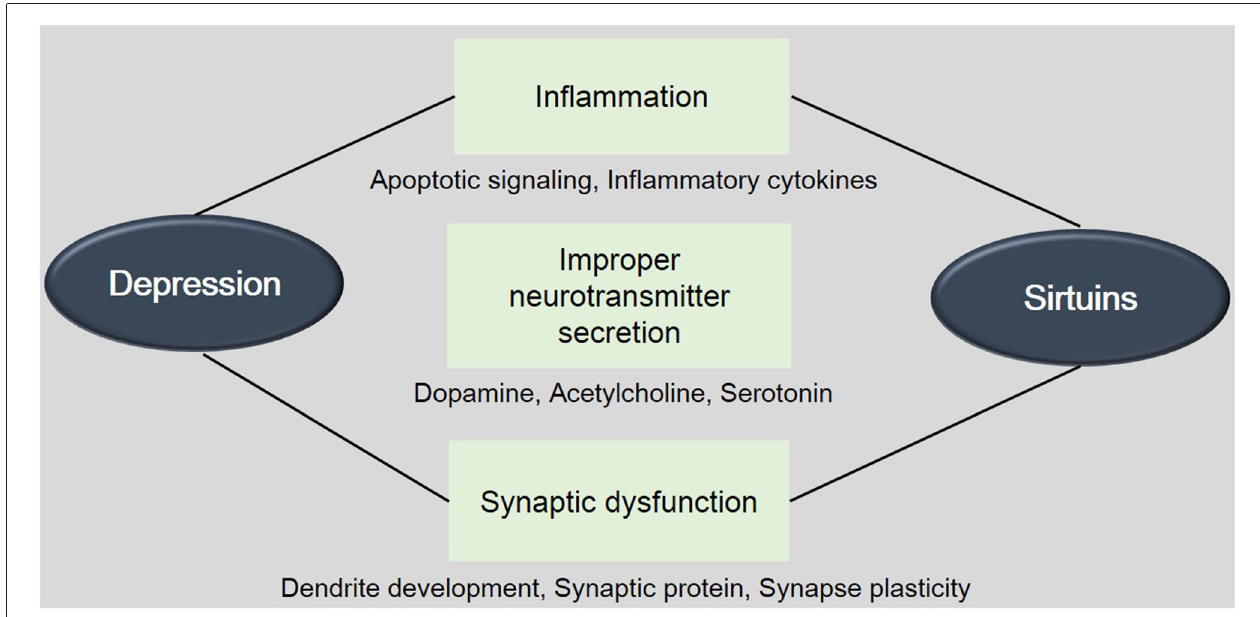
FIGURE 1 | The involvement between Sirtuins (SIRTs) and depression. This schematic image shows the relevance between SIRTs and depression. The onset and progress of depression is related with the inflammation, improper neurotransmitter’s secretion, and synaptic dysfunction. This image indicates the involvement of SIRTs in these mechanisms. Mets: Metabolic